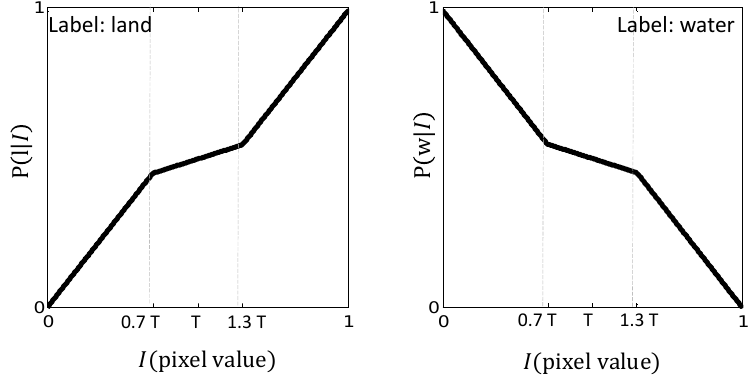
Figure 9. Functions that define the weight of each t-link.